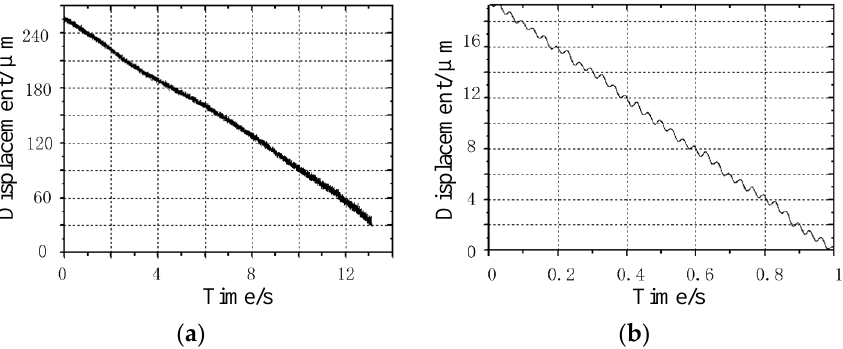
Figure 11. No-load operation curve of the prototype under the excitation frequency of 30 Hz: ( a ) travel curve of the prototype within 13 s; and ( b ) Travel curve of prototype within 1 s.